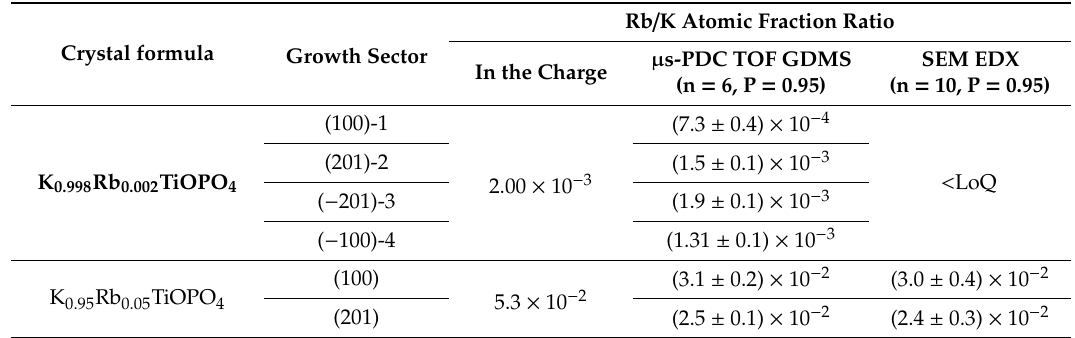
Table 3. Atomic fraction ratios of Rb / K in K 1 − x Rb x TiOPO 4 crystals (x = 0.002 and 0.05), determined by scanning electron microscope-energy dispersive X-ray spectroscopy (SEM EDX) and microsecond direct current pulsed glow discharge time-of-flight mass spectrometry ( µ s-PDC TOF GDMS) in di ff erent sector growth faces. For details on crystal cutting, please refer to Figure 1.